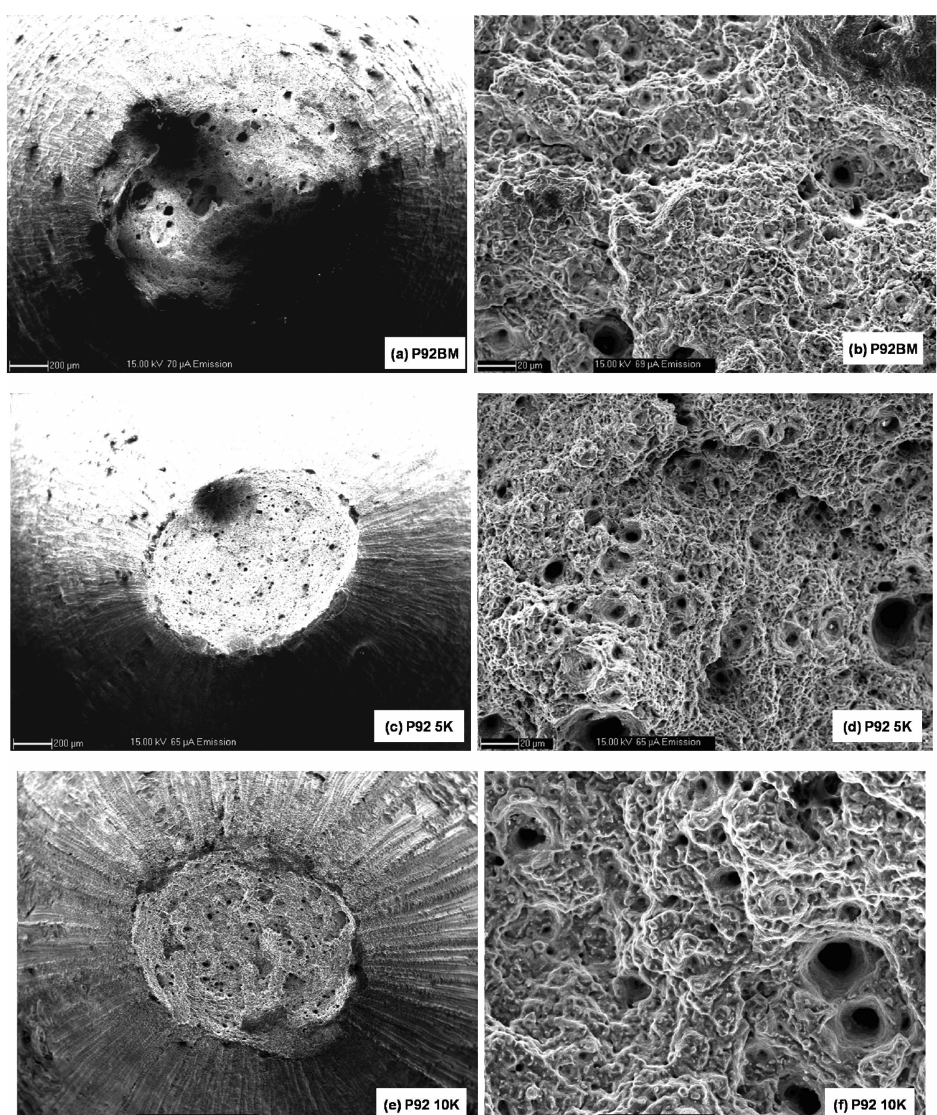
Figure 11: Fracture surface of the tensile tested P92 steel at 923 K in ((a) and (b)) normalized and tempered, and thermal aged ((c) and (d)) for 5000 h, and ((e) and (f)) for 10,000 h